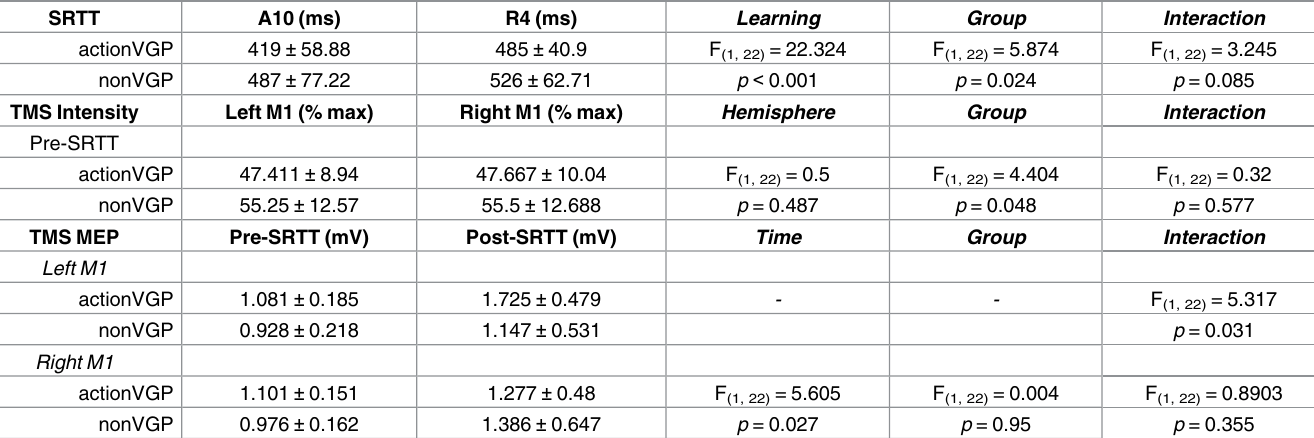
Table 1. Summaryof SRTT and TMS results.